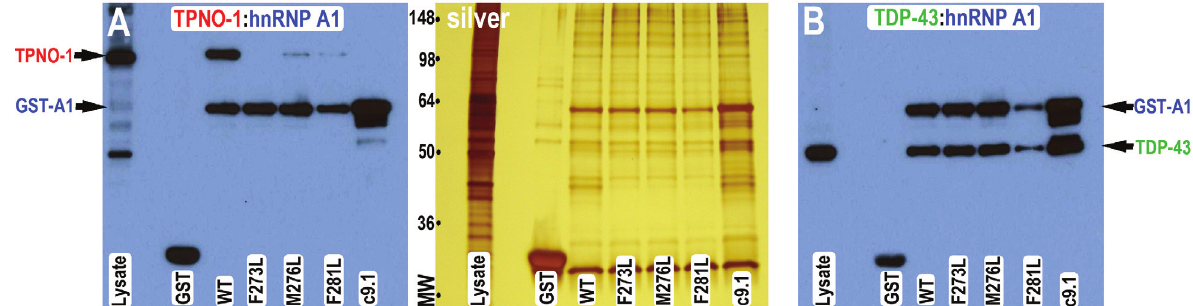
Figure 3. Western blots of hnRNP A1 binding with TPNO-1 and TDP-43. GST-tagged WT or mutant forms of hnRNP A1 were bound to Glutathione Sepharose 4B beads, protein lysates of SK-N-SH cells were applied to columns, and the resulting eluent was probed for either TPNO-1 ( A ) or TDP-43 ( B ). A . There was strong binding between WT hnRNP A1 and TPNO-1. In contrast, there was no binding between mutant hnRNP A1 (F273L) and TPNO-1, and markedly reduced binding between mutant hnRNP A1s (M276L, F281L) and TPNO-1. B . There was no change in binding between WT and mutant forms of hnRNP A1 and